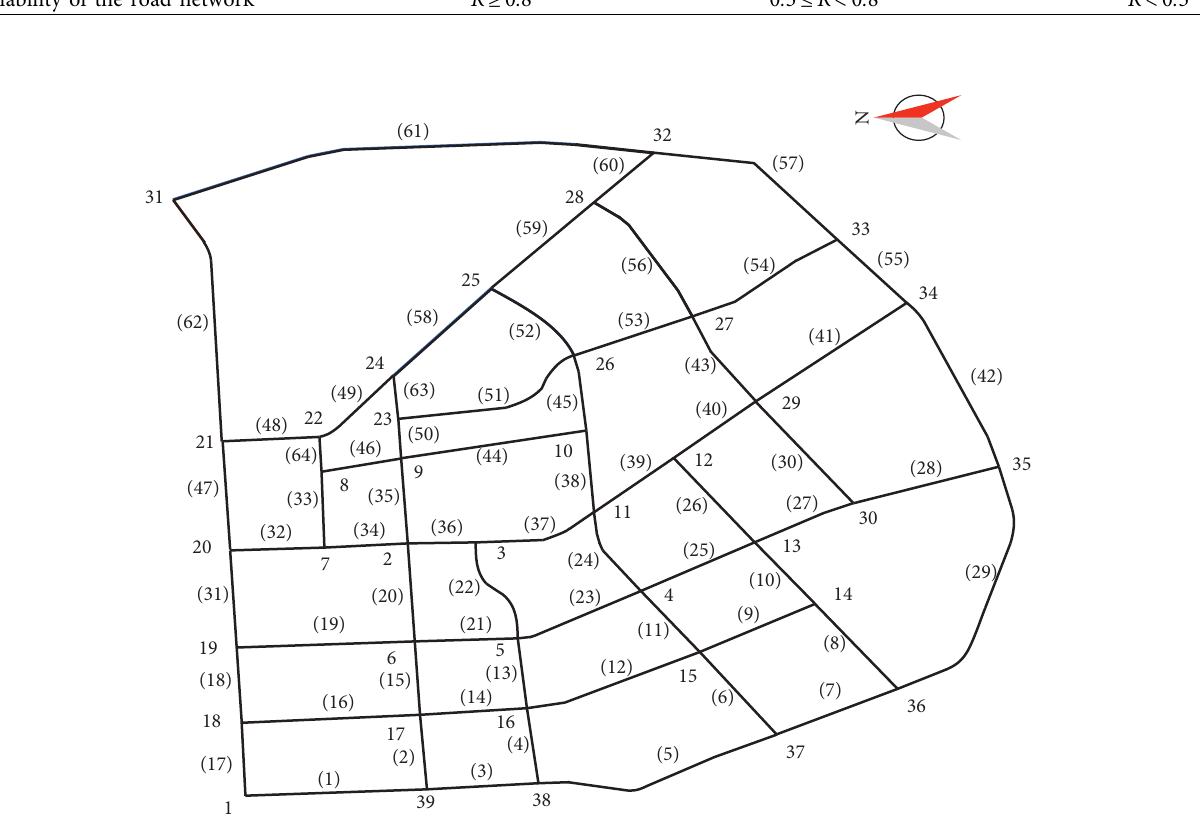
Figure 5: Road network plan. Table 9: Properties of the road